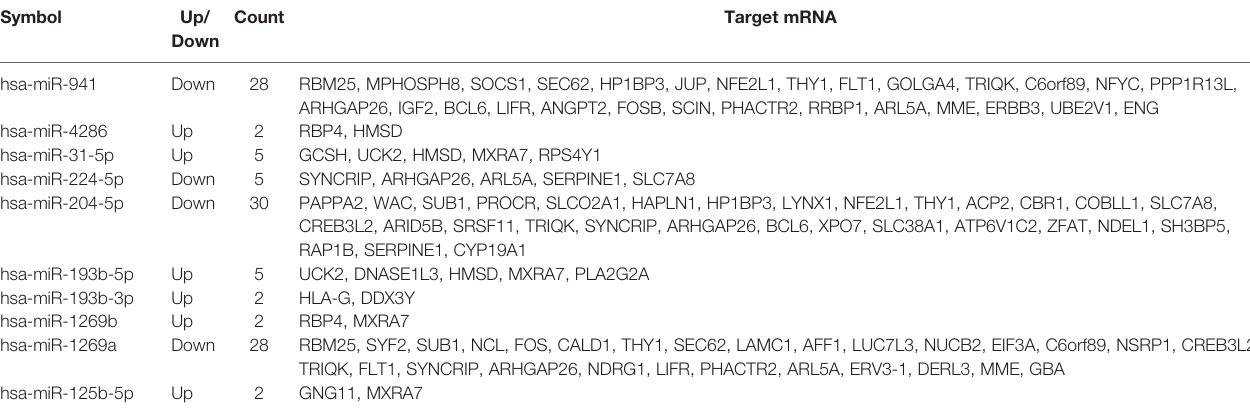
TABLE 5 | The miRNA-mRNA network. Symbol Up/ Count Target mRNA Down